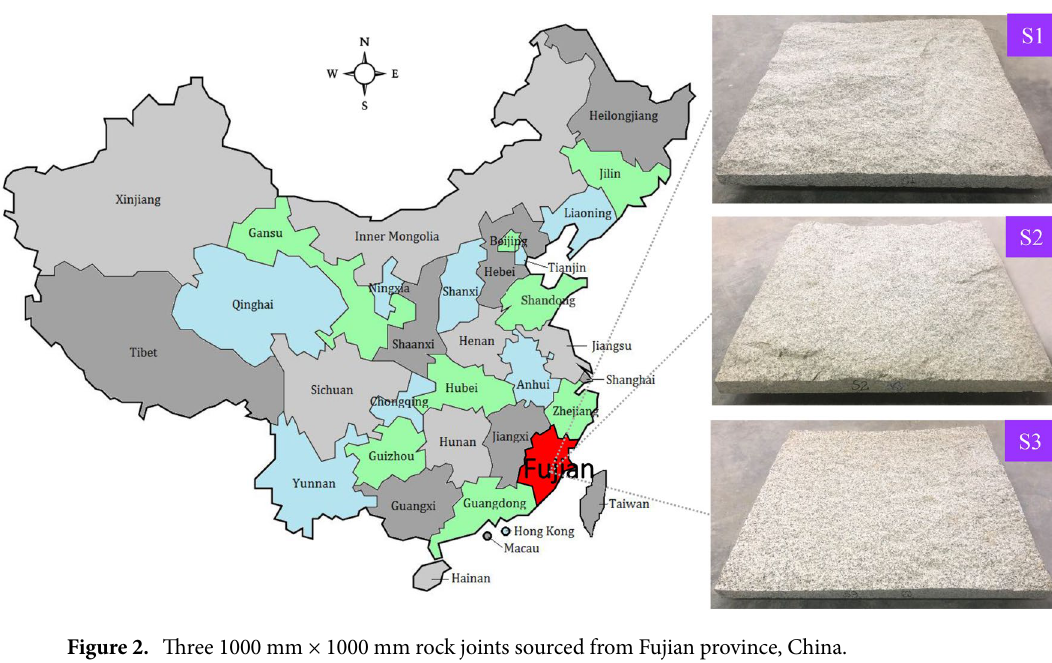
Figure 2. Three 1000 mm × 1000 mm rock joints sourced from Fujian province, China.